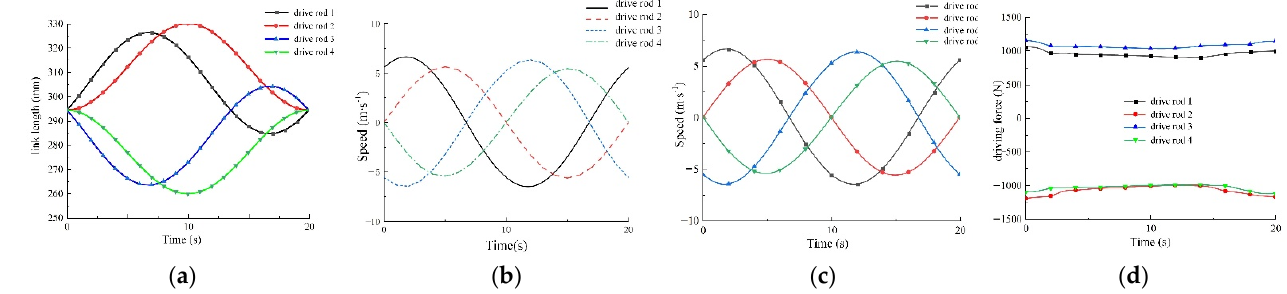
Figure 4. Theoretical curve ( a ) of rod length variation; ( b ) of velocity change; ( c ) of acceleration change; ( d ) of driving force change.